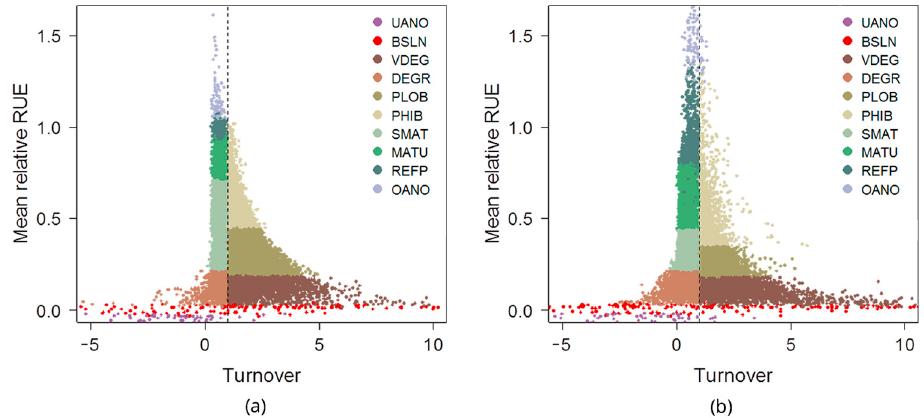
Figure 3. Change in mean relative RUE with turnover: ( a ) wet to semi-arid classes; ( b ) arid class. Locations are coded to assessment class (land state). Legend abbreviations: UANO: Underperforming anomaly ; BSLN: Baseline performance ; VDEG: Very degraded ; DEGR: Degraded ; PLOB: Productive with low biomass ; PHIB: Productive with high biomass ; SMAT: Submature ; MATU: Mature ; REFP: Reference performance ; OANO: Over-performing anomaly . Legend colors are consistent with Figure 4. A turnover threshold of one has been drawn to make the rules easier to interpret.